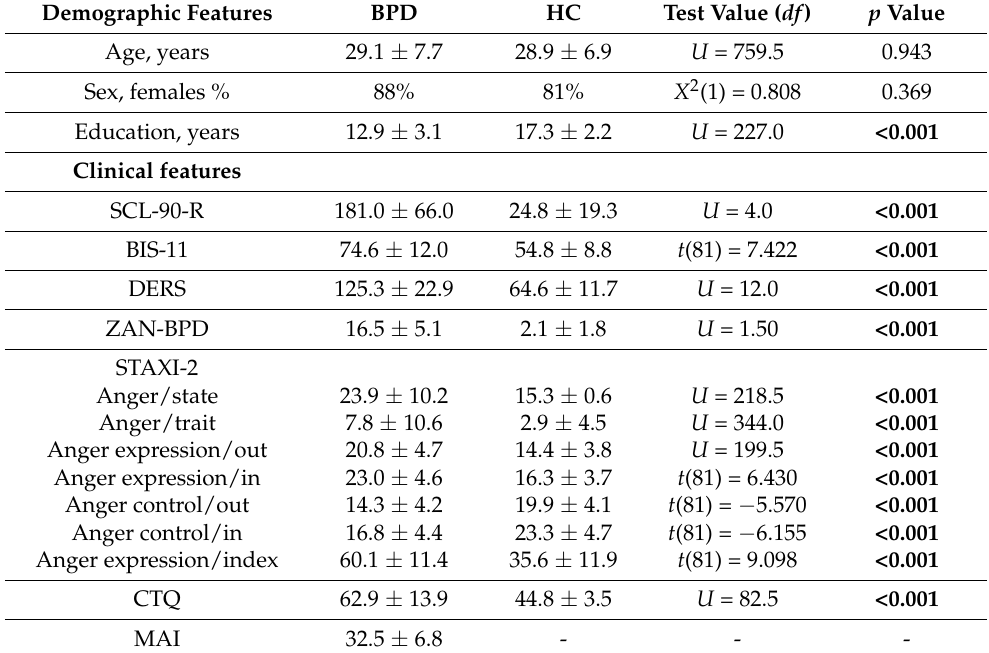
Table 1. Demographic and clinical features of Borderline Personality Disorder (BPD, n = 59) and healthy controls (HC, n = 26). Values are reported as mean ( M ) ± standard deviation ( SD ) or percentage (%). U denotes the Mann–Whitney U test value, t denotes the two-sample t -test value, X 2 denotes the Pearson’s chi-square test value, df denotes the degrees freedom, while p denotes their statistical significance (set to p < 0.050). Significant results are reported in bold